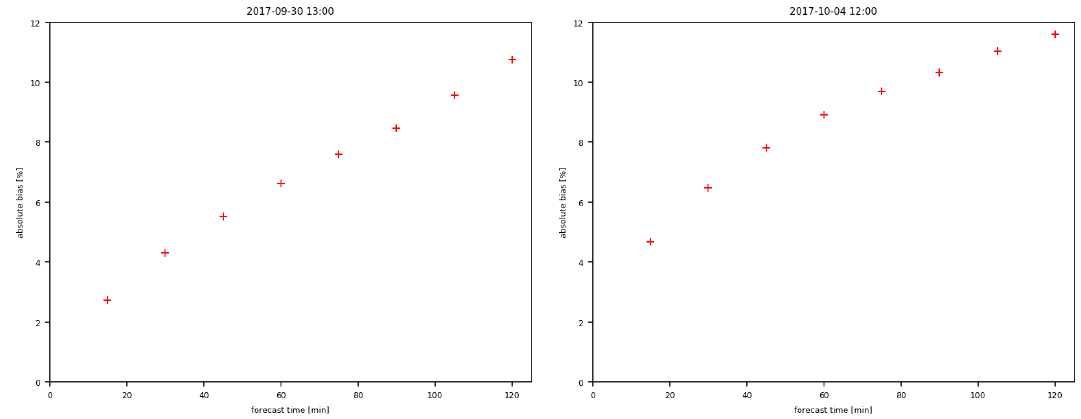
Figure 4. Plots of the absolute bias of the effective cloud albedo against the forecast time for the cases of 30 September 2017 at 13:00 UTC (situation with convection behind a front over Germany) and 4 October 2017 at 12:00 UTC (stratiform situation). The unit of the absolute bias is %.